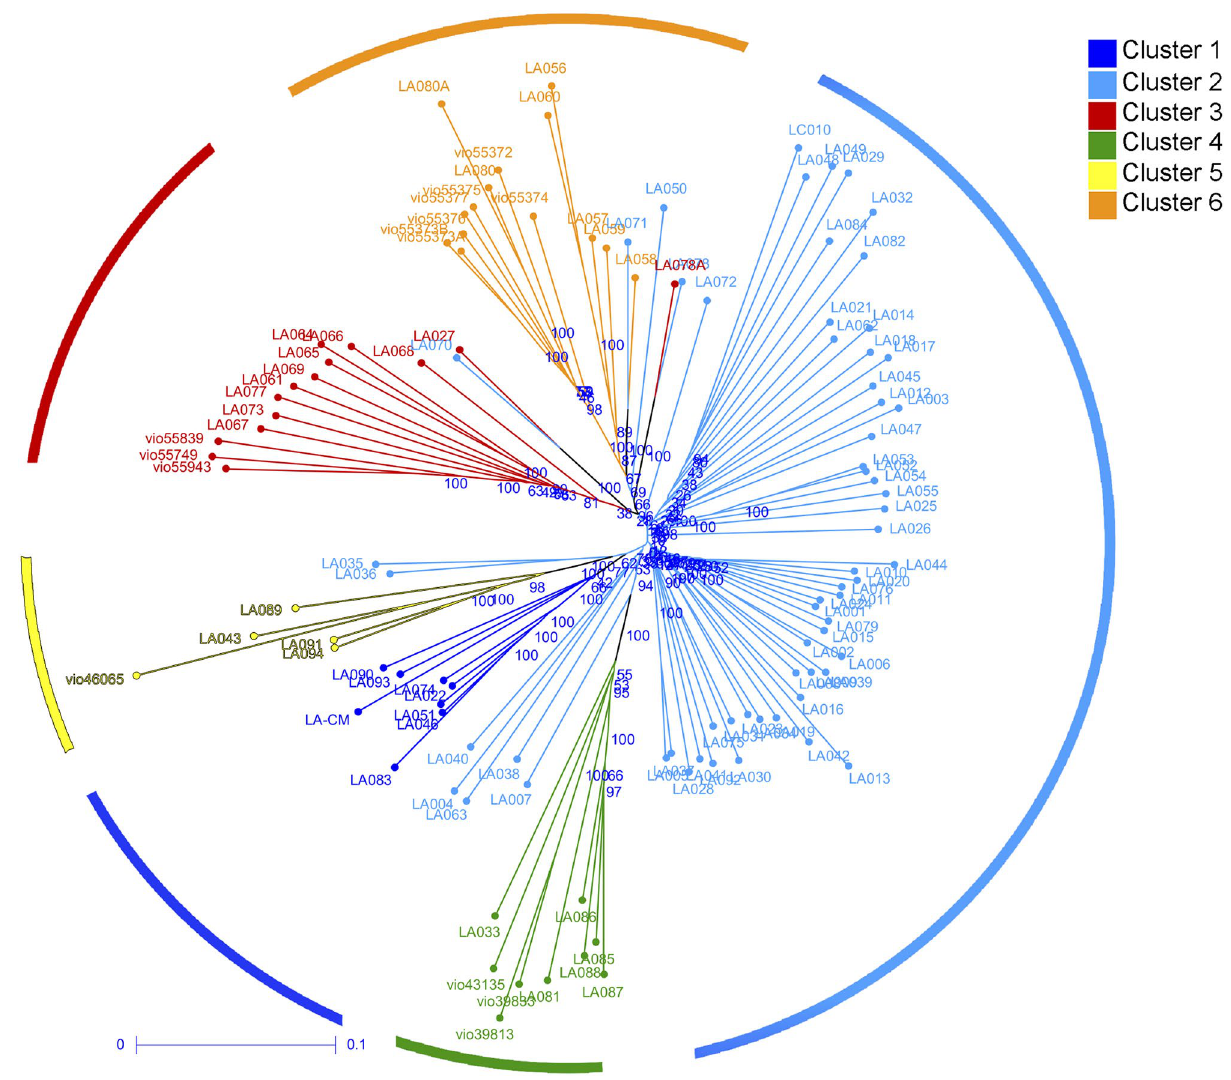
Figure 3. Phylogenetic tree among the 112 Luffa acutangula accessions. The colors of branches illustrate accessions belonging to different clusters acquired from STRU CTU RE analysis. Six clades were identified as indicated by circle population 25 . The H E as measure of genetic diversity ranges from 0.338 (Cluster 2) to 0.272 (Cluster 3) in the six clusters; the remaining cluster values are the following: Cluster 1 (0.274), Cluster 4 (0.295), Cluster 5 (0.287) and cluster 6 (0.334) (Table 1). The high H E in Cluster 2 also corresponds with the highest Shannon & Weiner diversity index (H) of 4.127. The H O for the STRU CTU RE grouping is as follows: Cluster 1 (0.378), Cluster 2 (0.388), Cluster 3 (0.191), Cluster 4 (0.289), Cluster 5 (0.363) and Cluster 6 (0.410) (Table 1). The H O > H E occurs in Cluster 1, Cluster 2, Cluster 5 and Cluster 6 (Table 1). The H O in Cluster 4 (0.289) is lower in value than the H E (0.295). Cluster 3 has the lowest H E (0.272) and H O (0.191) from all six subpopulations. The mean SNP polymorphism information content (PIC) has a range of values from 0.125 to 0.375, with a mean of 0.288 (Table 1). F-statistics is useful for inferring genetic diversity among and within populations. Moderate differen- tiation occurs among populations ( F ST = 0.137) and in the total fixation index ( F IT = 0.057), while a low fixation index occurs within populations ( F IS = − 0.092) (Table 1). Pairwise genetic differentiation is highest between Cluster 3 and Cluster 4 ( F ST = 0.262), while the lowest value occurs between Cluster 1 and Cluster 2 ( F ST = 0.089), and also between Cluster 2 and Cluster 3 ( F ST = 0.086) (Table 2). The Analysis of Molecular Variance (AMOVA) method approximates the population differentiation directly from the SNP data 26,27 . AMOVA based on STRU CTU RE clustering shows 12.83% variation among subpopulations and a negative AMOVA variance within subpopulations (− 10.59%) (Table 3). Phi-statistics ( ) gives an overview of the level of differentiation between clusters. According to the phi-statistics, a moderate ϕ degree of differentiation occurs between STRU CTU RE clusters ( = 0.128) 28,29 . Cluster 1 and 2 represent the genetic admixture found in Thailand, while Cluster 3 exhibits the genotype from ϕ Laos, as seen from the STRU CTU RE analysis (Fig. 5). Accessions from Vietnam, the Philippines and Indonesia